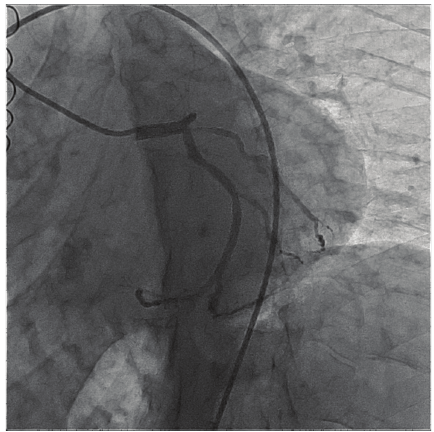
Figure 2: Angiography showing total occlusion of the proximal left anterior descending artery, with moderate lesions in the mid- circumflex artery and in the proximal first marginal branch.